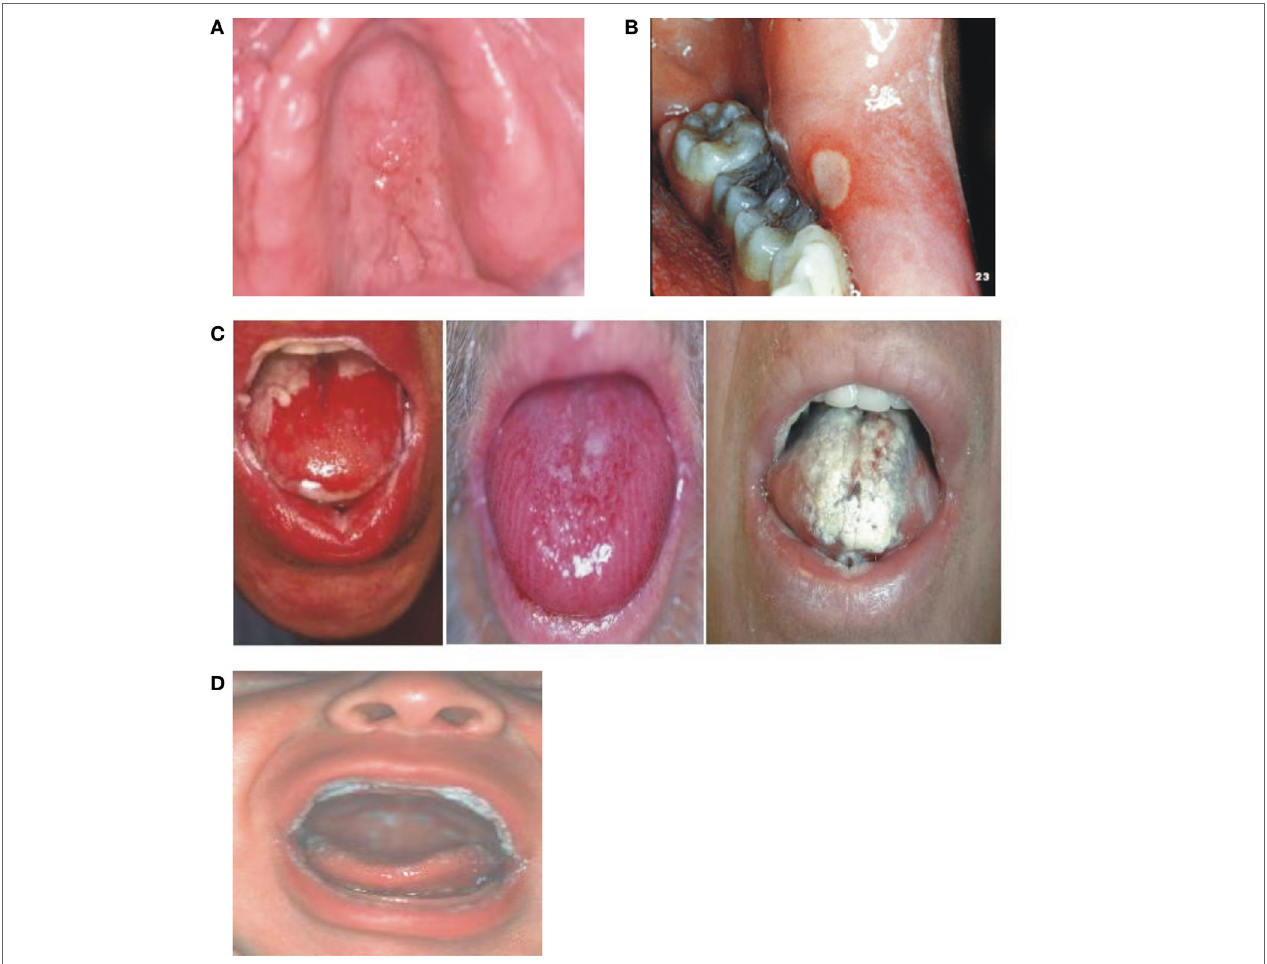
FiGuRe 5 | Differential diagnosis of radiation-induced oral mucositis . Republished with the permission of Dr. Patrick Stiff, Loyola University Medical Center, Maywood, IL, USA. (A) Local, denture-related lesion, (b) aphthous ulcer, (C) oral mucositis, and (D) oral thrush.